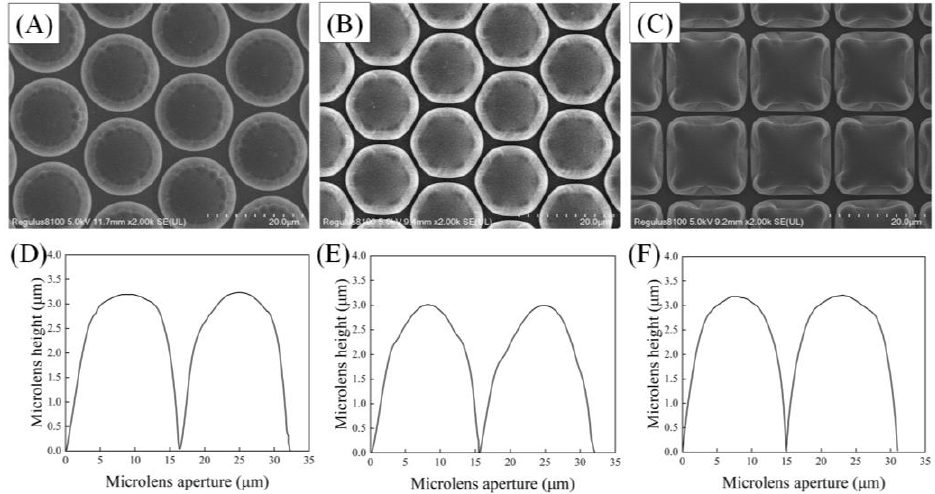
Figure 5. The SEM images and the surface profiles of ( A , D ) circular, ( B , E ) hexagonal, and ( C , F ) square photoresist film MLAs.